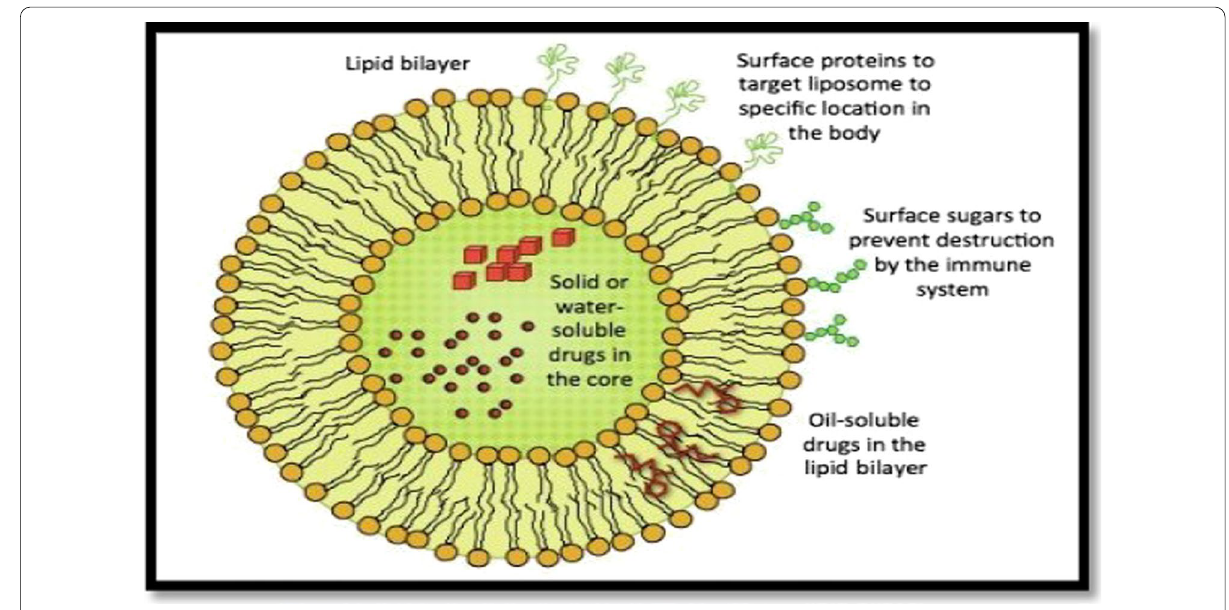
Fig. 6 Schematic representation of liposomes